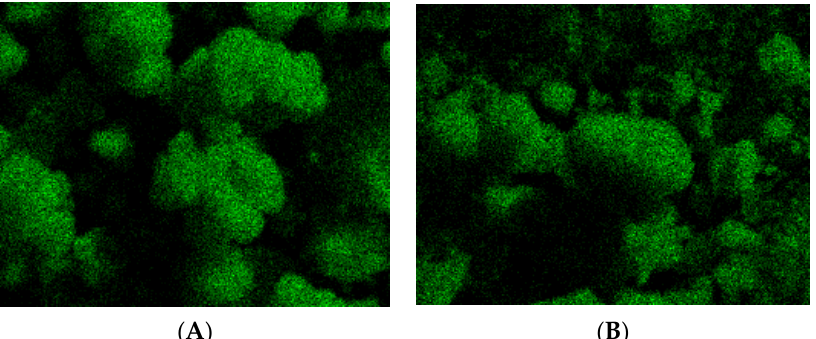
Figure 1. Energy dispersive spectroscopy (SEM-EDS ) mapping image of Co in catalysts( A ) AuDpCoZ and ( B )AuDpCoZt.